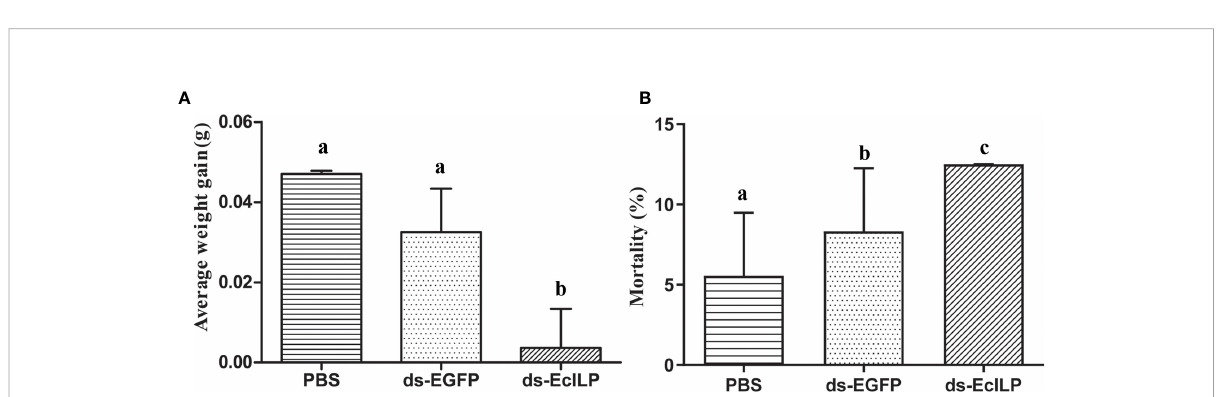
FIGURE 8 Growth performance of E. carinicauda under different treatments. (A) average weight gain, (B) mortality rate (%). Error bars refer to the standard deviation. Different letters on the bars indicated the difference signi fi cance ( P value < 0.05). Each group (PBS group, ds-EGFP group, and ds- EcILP group) used 75 adult E. carinicauda .